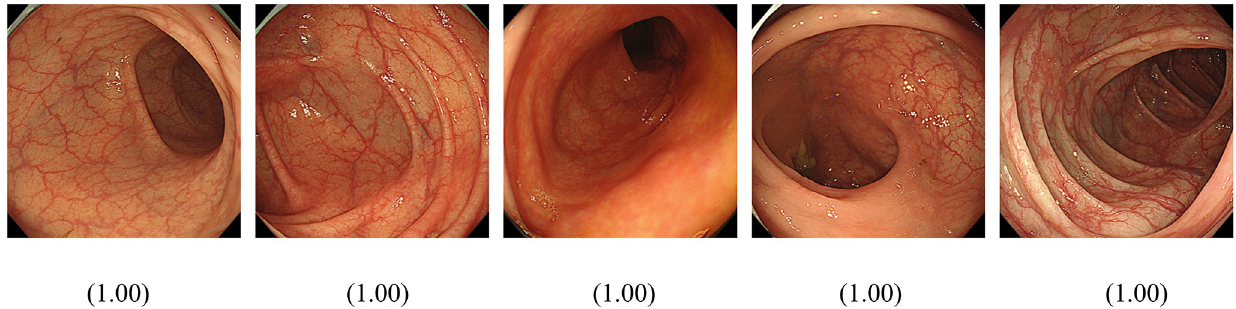
Fig 6. Images that scored high (0 to 1) in the colon image AI model for detecting Group D are shown. Values shown correspond to score.